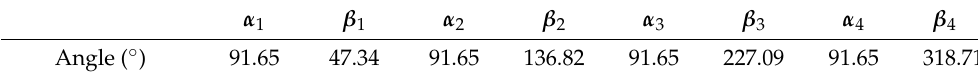
Table 2. Solution results of optimal grasping